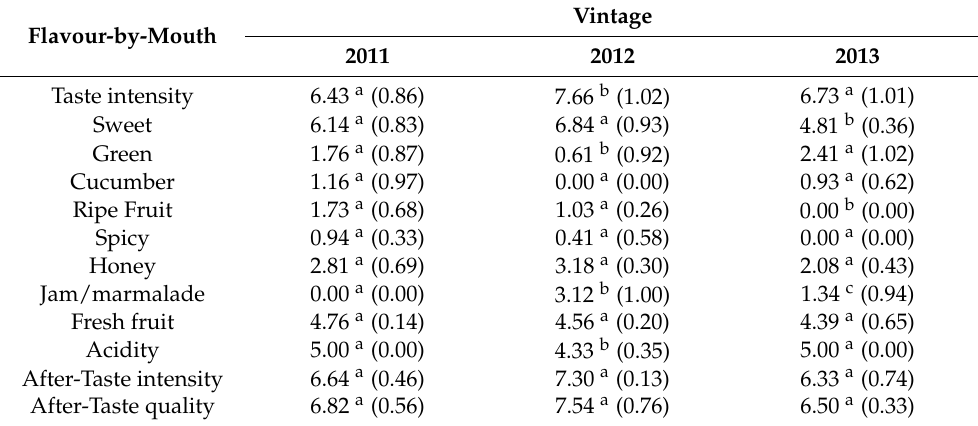
Table 5. Mean gustative profile of melon scores of 15 judges and standard deviations (two replicates).